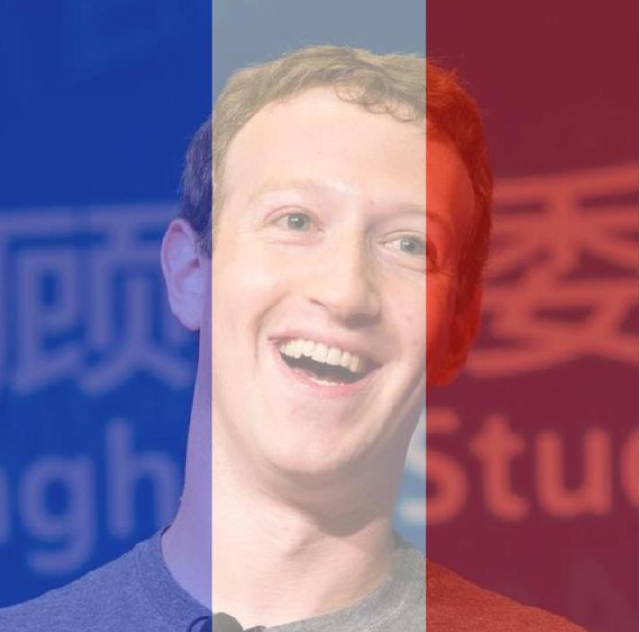
Figure 1. The profile picture of Mark Zuckerberg, founder of Facebook, superimposing the French flag in a sign of solidarity after the Paris bombings. Source: Wendling 2015